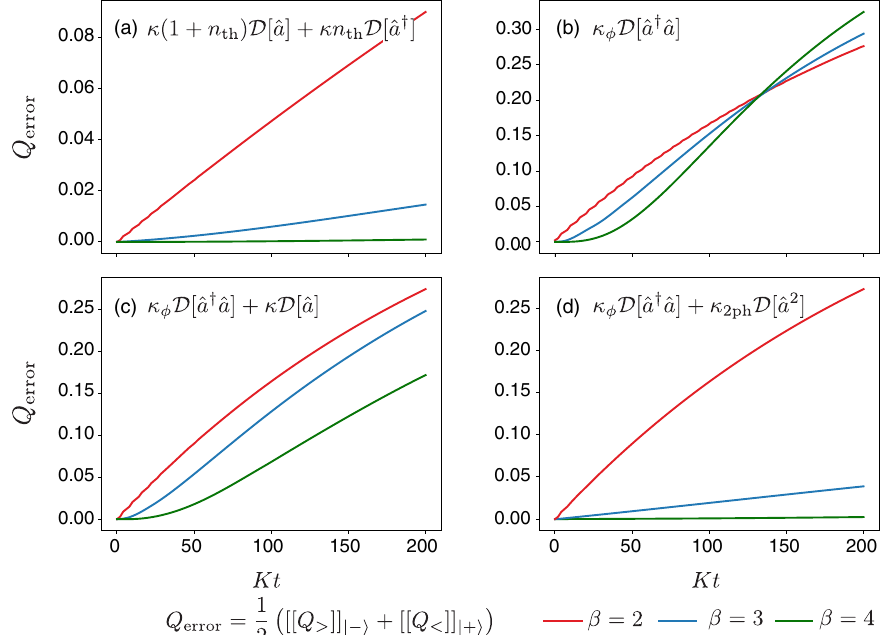
_ ˆ ρ ˆ H ; ˆ ρ (cid:2) þ L ½ ˆ ρ (cid:2) with ¼ − i ½ PCO D ½ ˆ a † ˆ a (cid:2) þ κ D ½ ˆ a 2 (cid:2) ϕ 2 ph